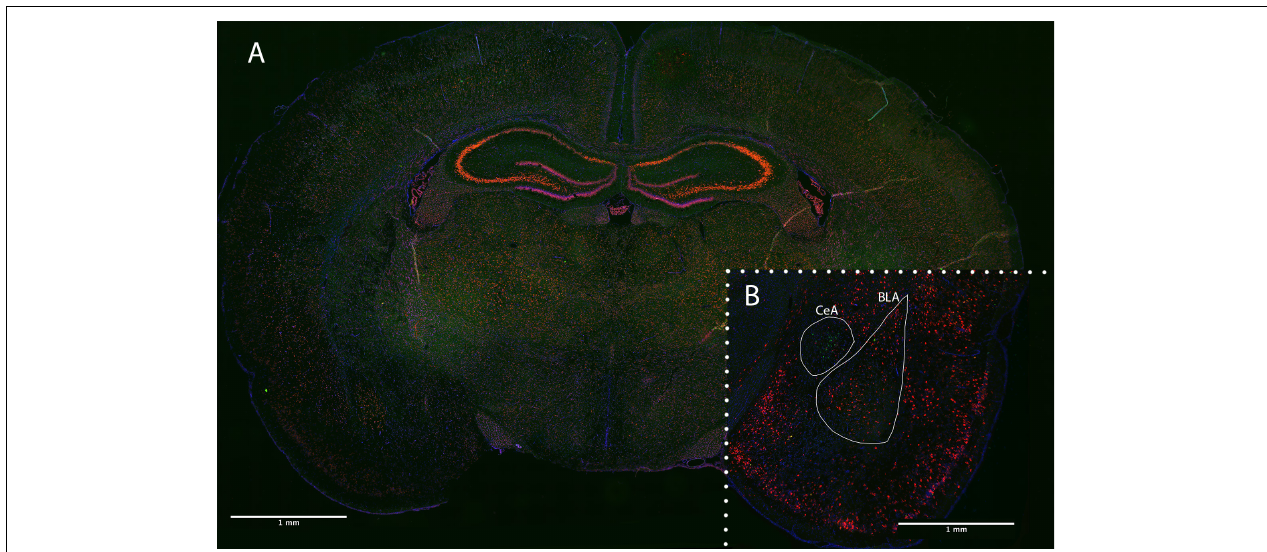
FIGURE 3 | Coronal brain section of PND 24 rat following RNAscope FISH. (A) Optimized positive control section staining Polr2a (green), PPIB (red), and DAPI (blue). (B) Experimentally stained section staining CRF (green), c-fos (red), and DAPI (blue). Quantified amygdala regions (BLA and CeA) indicated in a female, fear-conditioned, handled experimental